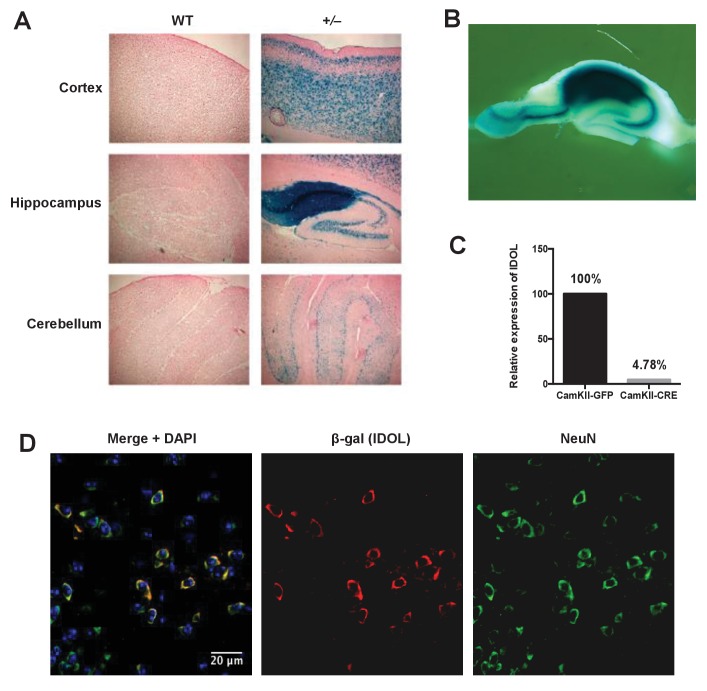
IDOL is a dominant regulator of neuronal ApoE receptor abundance.(A) X-gal staining of brain sections from 8-week-old WT and IDOL-deficient mice. Representative images of cortex, hippocampus and cerebellum are shown. (B) Whole-mount X-gal staining of hippocampus from IDOL-deficient mice. (C) Real-time PCR analysis of IDOL mRNA expression in Mylipflox/flox cortical neurons transduced with either AAV-CamKII-GFP or AAV-CamKII-CRE-GFP. (D) Representative images showing immunofluorescence staining of brain sections from the frontal cortex of IDOL-deficient mice. Green, NeuN (neuron); red, β-Gal (IDOL); blue, 4′,6-diamidino-2-phenylindole (DAPI; nucleus). Scale bars, 20 μm.